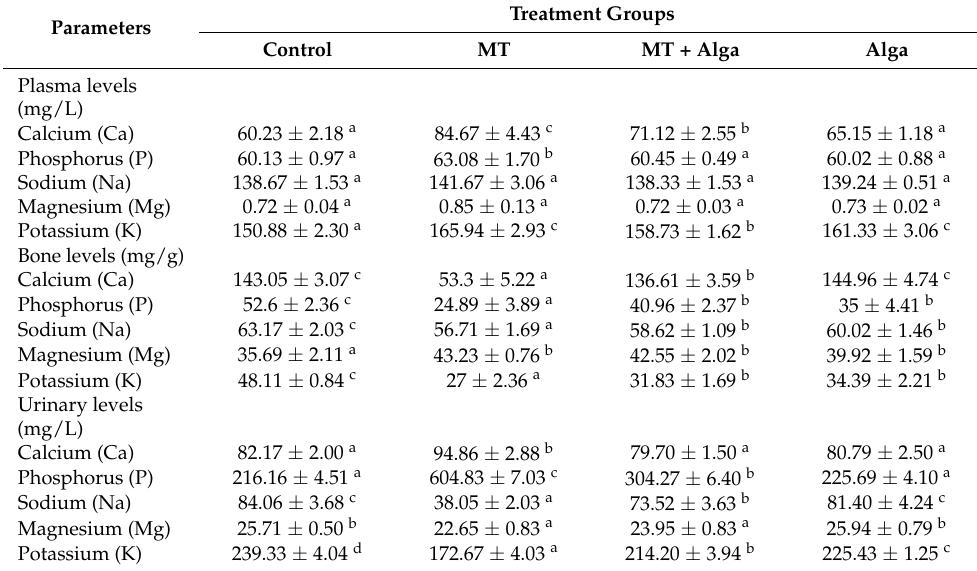
Table 4. Mineral content levels in the bone, blood, and urine of controls and rats treated with MT, MT + alga, and alga after 7 days.